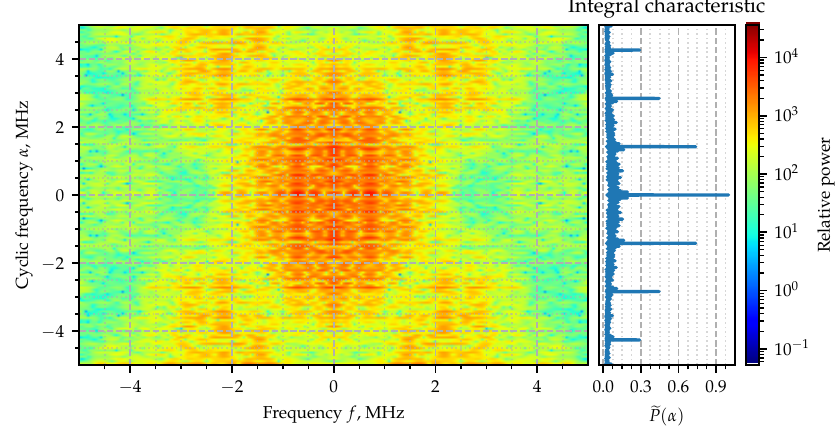
Figure 10. Estimated spectral correlation density of the PAM signal (zoomed version).